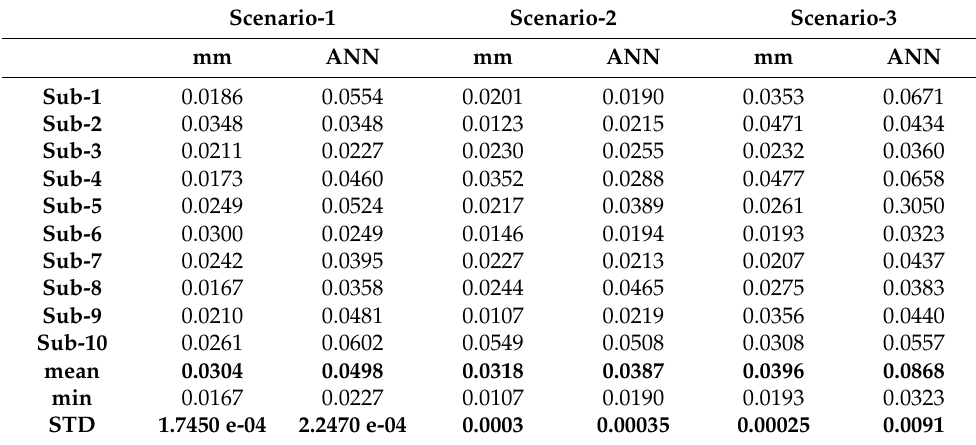
Table 3. Evaluation of the performance in terms of RMSE.